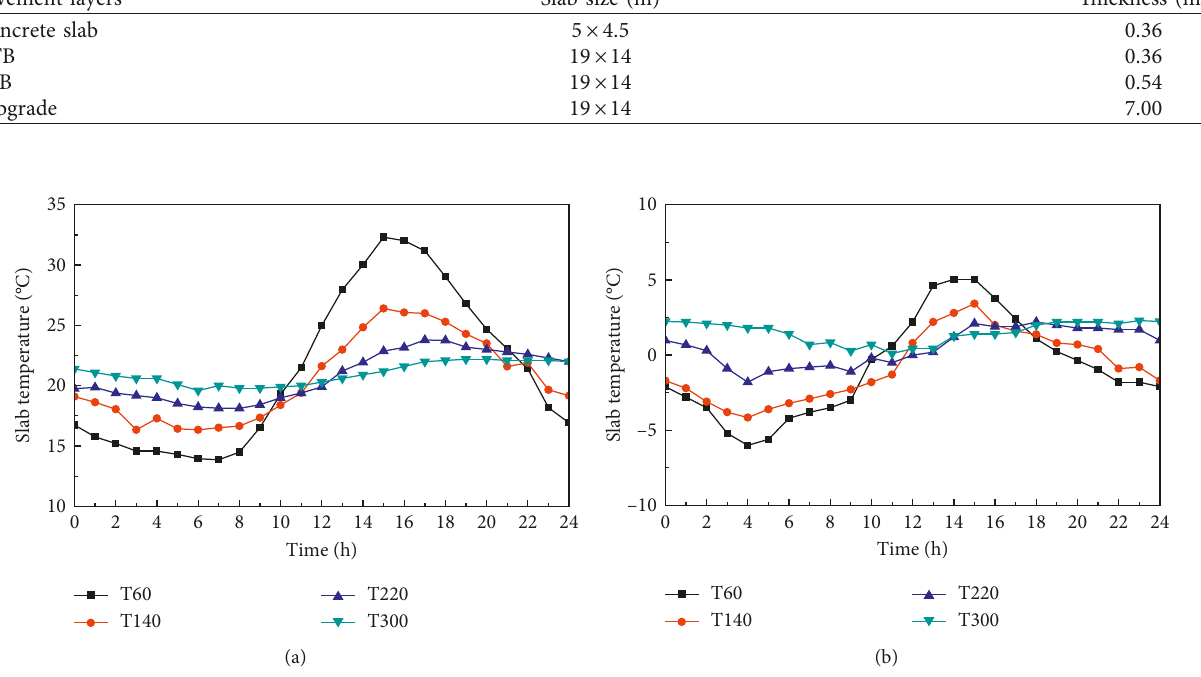
Figure 1: Pavement structure and layout of (a) temperature sensors (unit: mm) and (b) strain sensors (unit: mm). (c) Field layout of temperature and strain sensors. Table 1: Structure parameters of airport pavement layers. Pavement layers